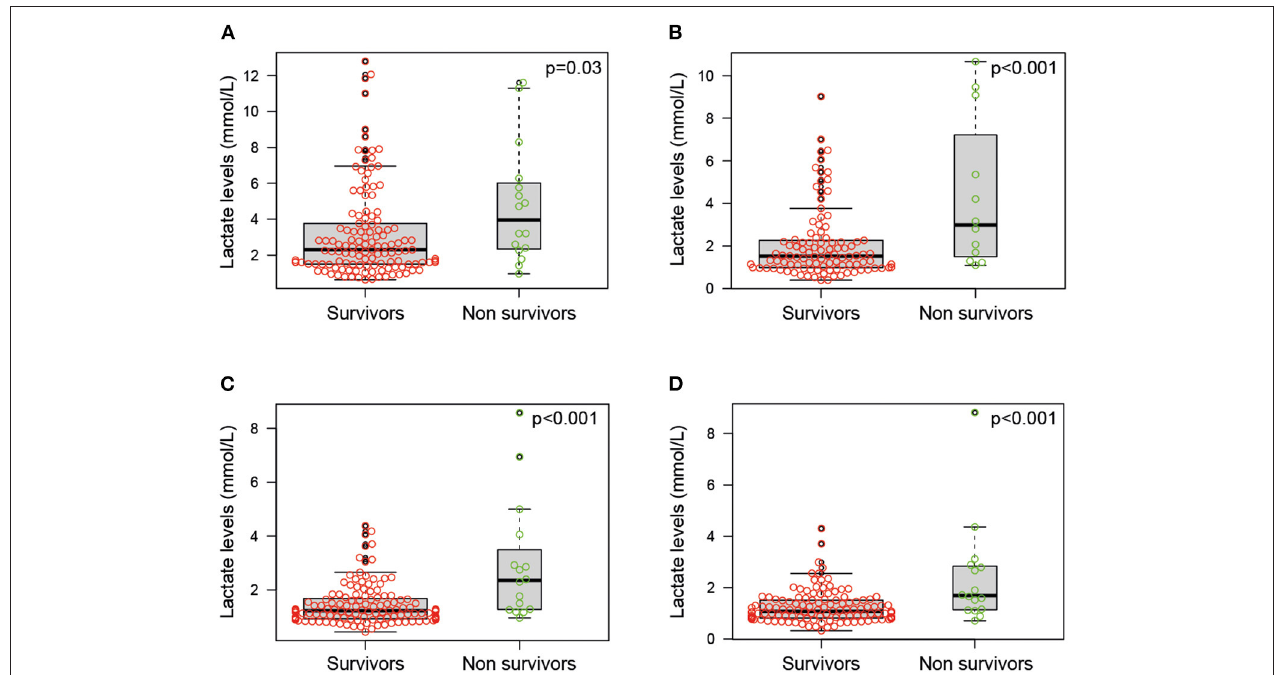
FIGURE 5 | Lactate levels in patients who did not survive 90 days after surgery (A) during the first hour after admission, (B) between 1 and 6h after admission, (C) between 6 and 24h after admission, and (D) between 24 and 48h after